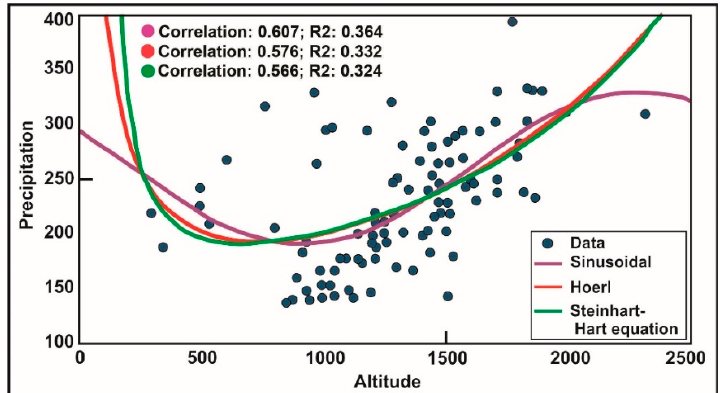
Figure 6. Scatter plot displaying altitude and annual precipitation data of the gauging stations in the study area, and the regression lines of the three applied non-linear regression methods.